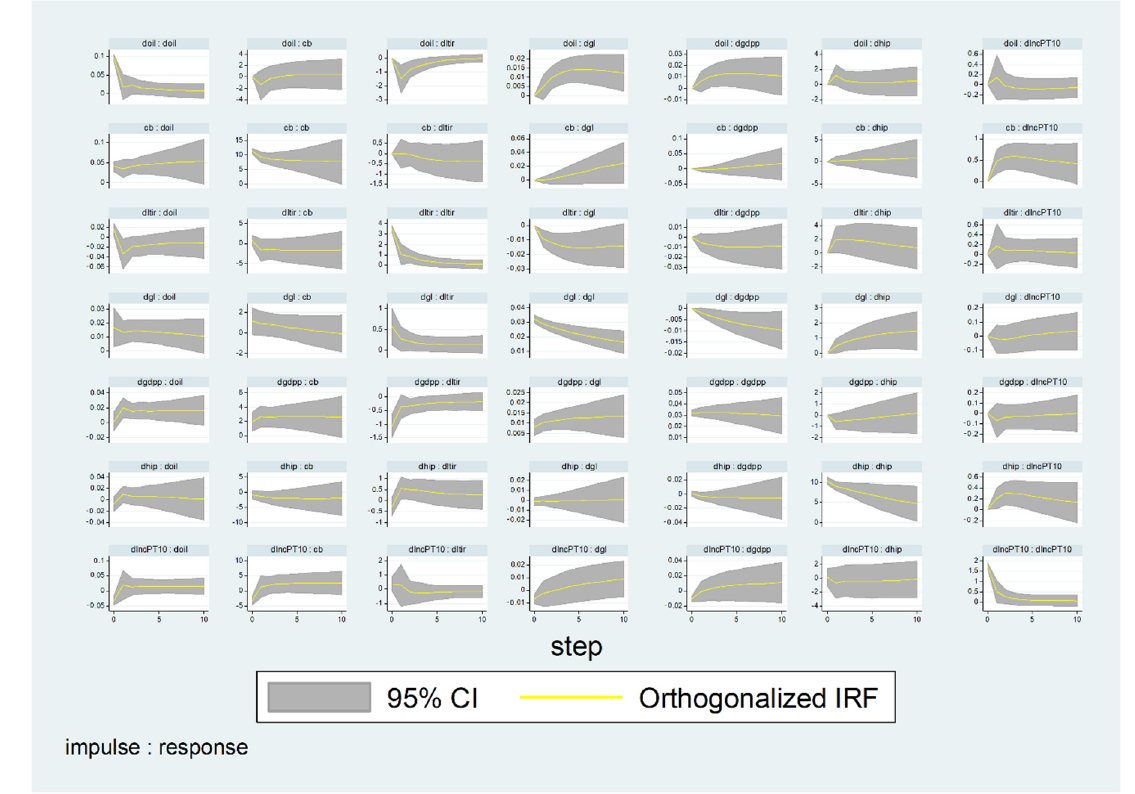
Figure A4. Response of inequality on unconventional monetary policy (income-composition channel). Note: The shaded areas refer to the 95% confidence band. Moreover, the IRFs present two periods, which are a short run from zero to four years and a long run from five to 10 years. Therefore, the orthogonalised IRF is interpreted aligned with the short-run and long-run periods as defined. Source: Author’s illustration based on SWIID (Solt 2020; World Development Indicators 2022).